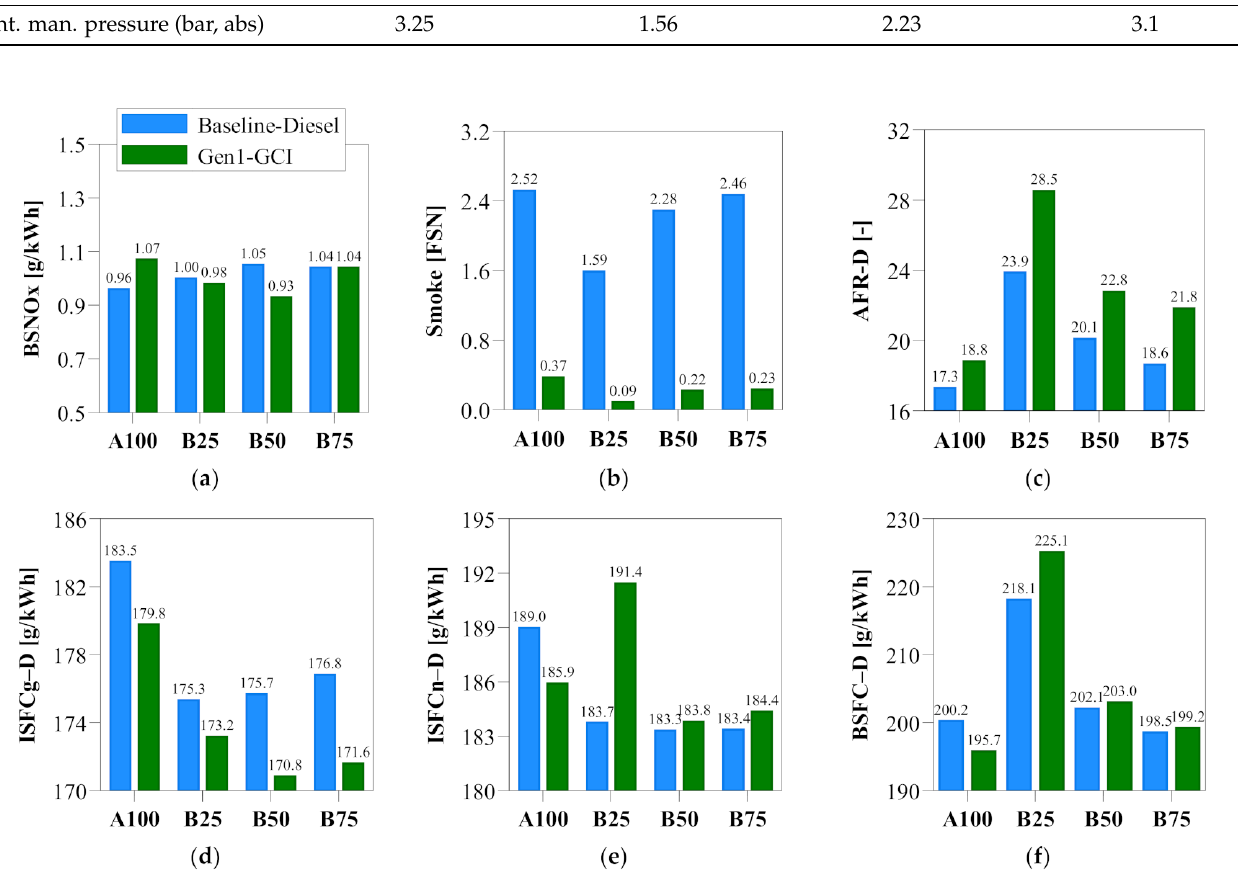
Figure 5. Overview of Gen1 GCI performance results: ( a ) BSNOx; ( b ) smoke; ( c ) AFR-D; ( d ) ISFCg-D; ( e ) ISFCn-D; ( f )